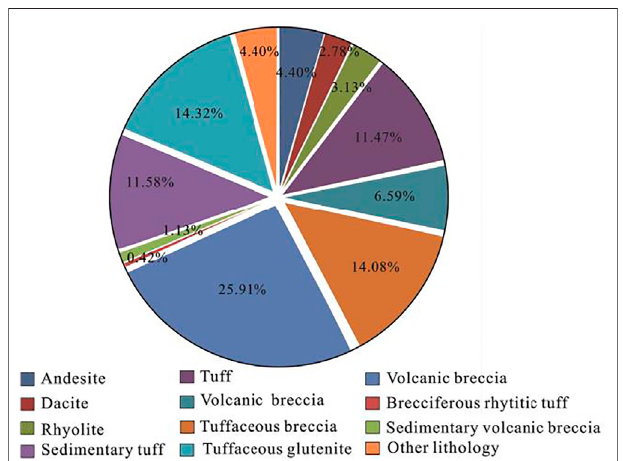
FIGURE3| LithologiccontentratiooftheMesozoicvolcanicrocksinthe D oil fi eld of the Laizhouwan sag.